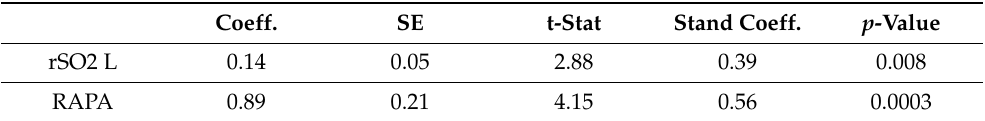
Table 4. MOCA/rSO2 front L/RAPA multiple linear regression (adjusted R 2 = 0.61; MOCA = 16.918 + 0.889 RAPA + 0.135 rSO2 front L). Coeff.